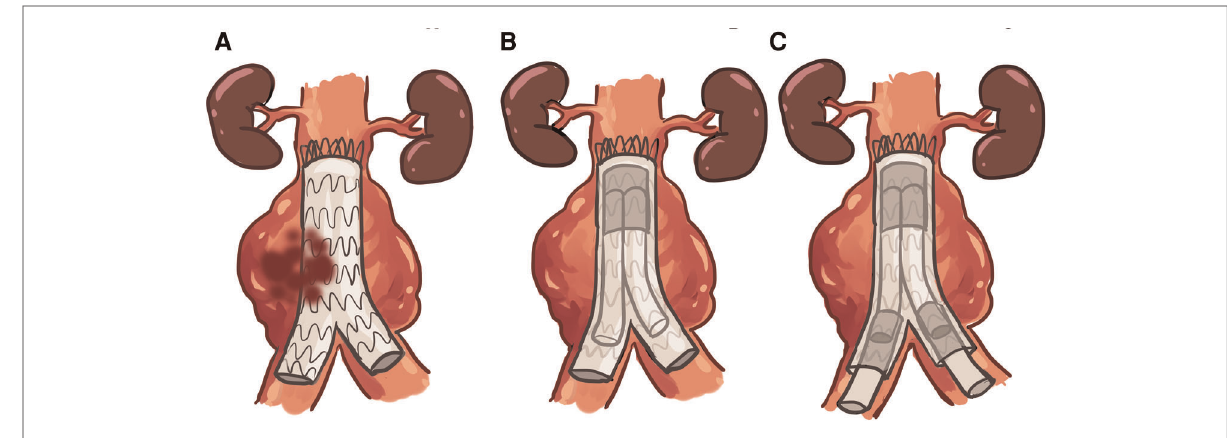
FIGURE 4 EVAR GORE SalvAge Fabric Technique (ARAFAT) is our protocol used to seal the type IIIb EL. ( A ) Microleaks at the endograft. ( B ) Oversized EXCLUDER® aortic cuff (GORE®, Flagstaff, Arizona, USA) deployed into the previously implanted stent-graft. ( C ) Simultaneous deployment of an EXCLUDER® iliac extension, as necessary, in double-barrel con fi guration from the main